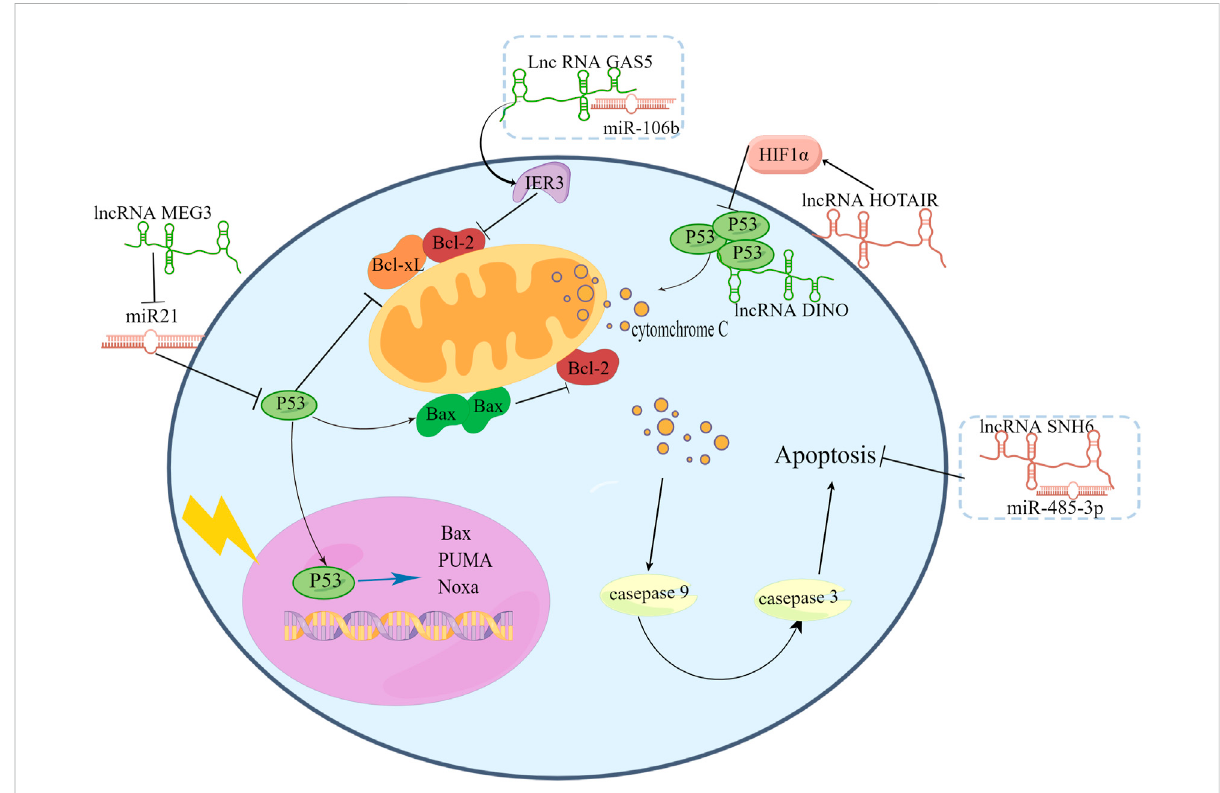
FIGURE 3 LncRNAs affect signaling pathways such as p53 or miRNA sponges to affect cervical cancer cell